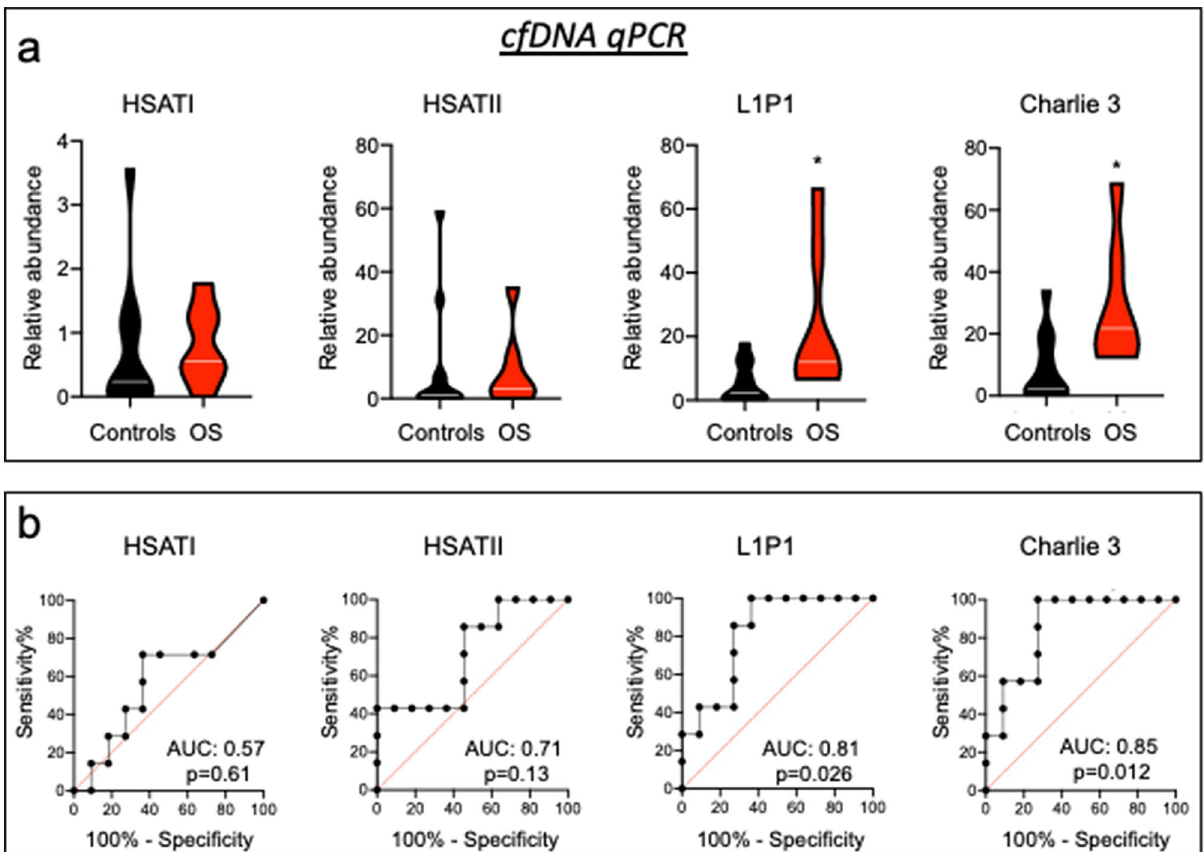
Figure 6. Human satellite sequences not enriched in total cfDNA in OS patient sera. ( a ) Violin plots representing relative abundance of HSATI , HSATII , L1P1 and Charlie 3 by qPCR of control (n = 11) and OS (n = 7) whole serum. White lines represent median. ( b ) Diagnostic value of HSATI , HSATII , L1P1 and Charlie 3 in OS patient whole serum. ROC curves were generated using data in ( a ). Groups were compared using two- tailed, unpaired, Mann Whitney U test; * p <